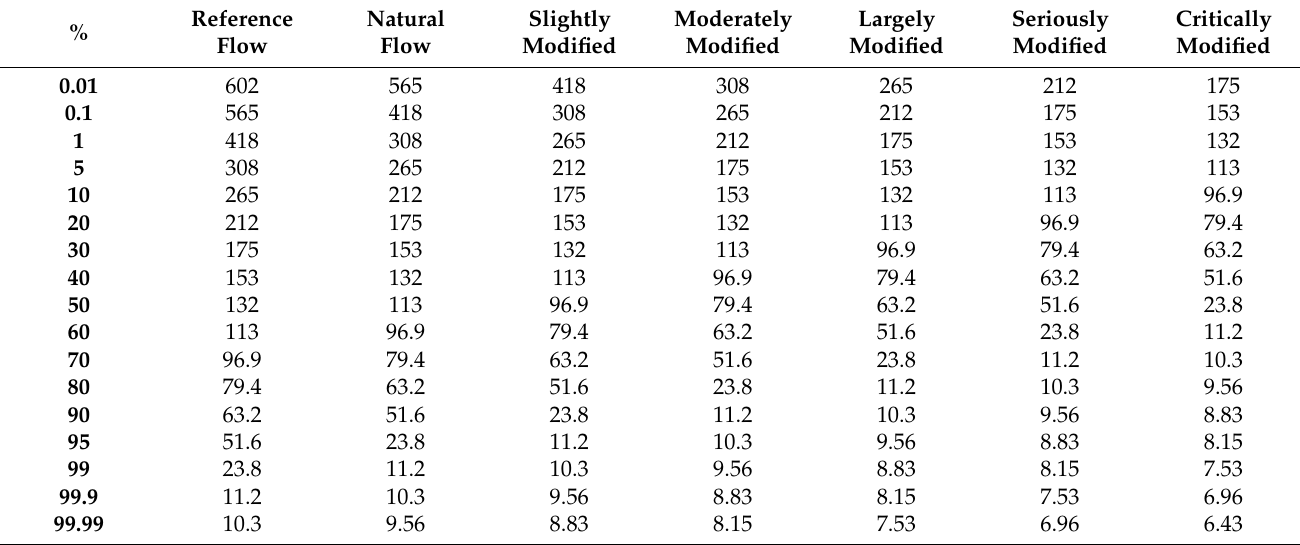
Figure 3. Monthly Mean Rainfall Trend Analysis. Table 2. Environmental Management Classes of the Selangor